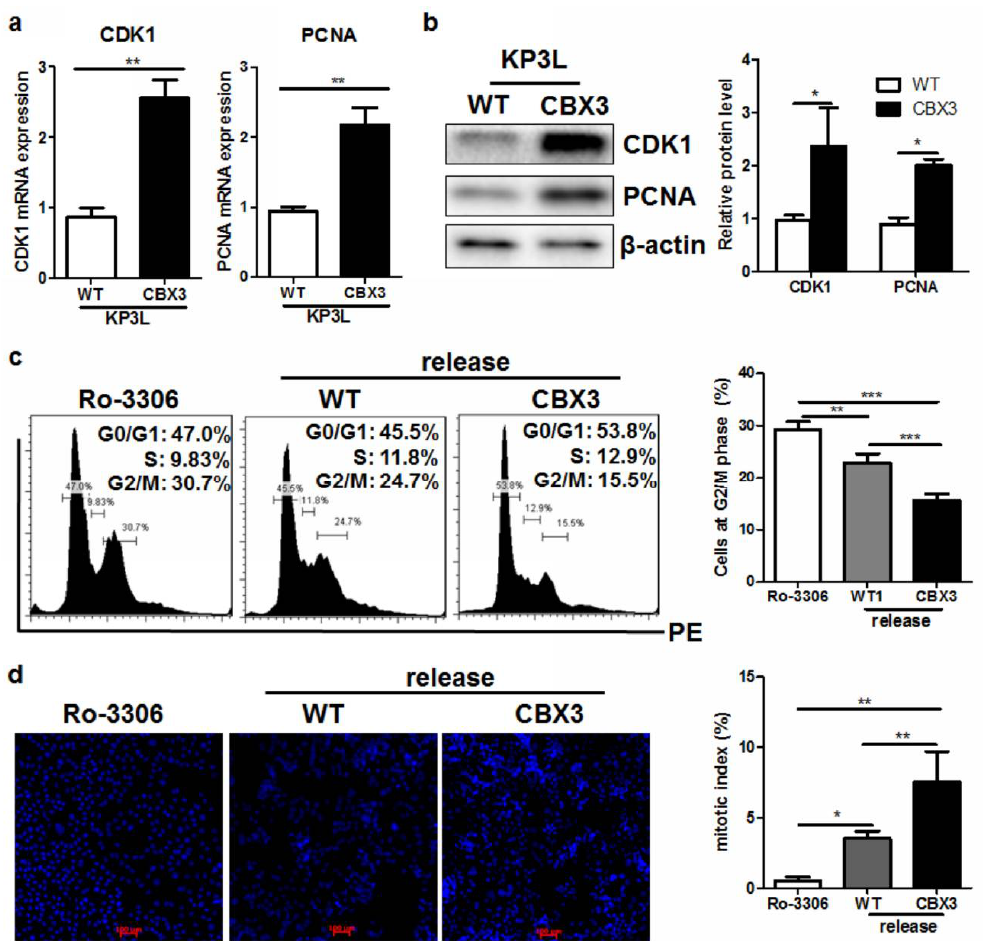
Figure 5. CBX3 overexpression promoted G2/M cell cycle transition. ( a ) mRNA expression of CDK1 and PCNA was increased in CBX3-overexpressing KP3L cells; ( b ) Protein expression of CDK1 and PCNA was increased in CBX3-overexpressing KP3L cells; ( c ) KP3L cells were arrested at G2/M phase by treatment of 5 µ M Ro-3306 for 12 h. Medium was then replaced with fresh full medium and allow cell cycle progression for another 12 h. It was found that treatment of Ro-3306 accumulated cells at G2/M phase, and after release CBX3-overexpressing cells showed a more rapid transition of cell cycle as evidence of low G2/M portion; ( d ) KP3L cells were fixed and stained with DAPI. Cells with condensed nuclear were counted as mitotic cells under fluorescence microscope. Percentage of mitotic cells out of total viable cells was calculated as mitotic index. CBX3-overexpressing cells showed higher mitotic index than WT cells. In all panels, * p < 0.05, ** p < 0.01 and *** p < 0.001 when comparison